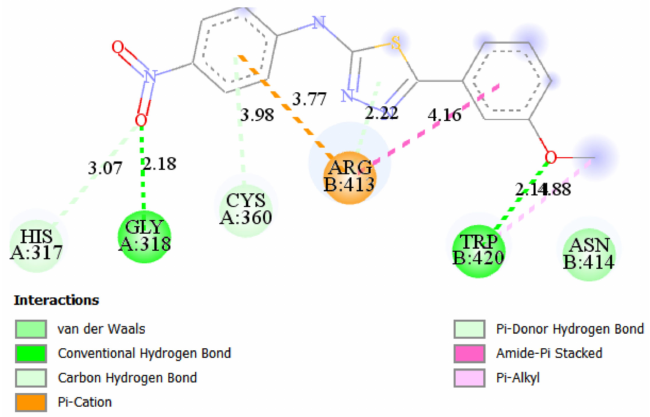
Figure 5. 2D and 3D interaction maps of ST15 with Caspase 8. The most active according to the biological assays, ST10 shows the best binding affinities ( − 7.34 kcal/mol, Ki = 4.16 µ M) for Caspase 8 and ( − 7.43 kcal/mol, Ki = 3.56 µ M) for Bax-protein. In the ST10–Caspase8 complex, the hydrogen bonds are observed with ARG260 (1.93 Å) and TRP420 (2.89 Å) amino acid residues (Figure 6). The trifluoromethyl group forms a number of halogen interactions with electron-poor species of TYR12 and ARG413. Lipophilic aminoacids ALA359, CYS360, ARG413, and ARG413 connect to the ST10 by different types of hydrophobic interactions. In addition, carbon and Pi-donor hydrogen bonds contribute to the stabilization of the ST10–Caspase 8 complex.